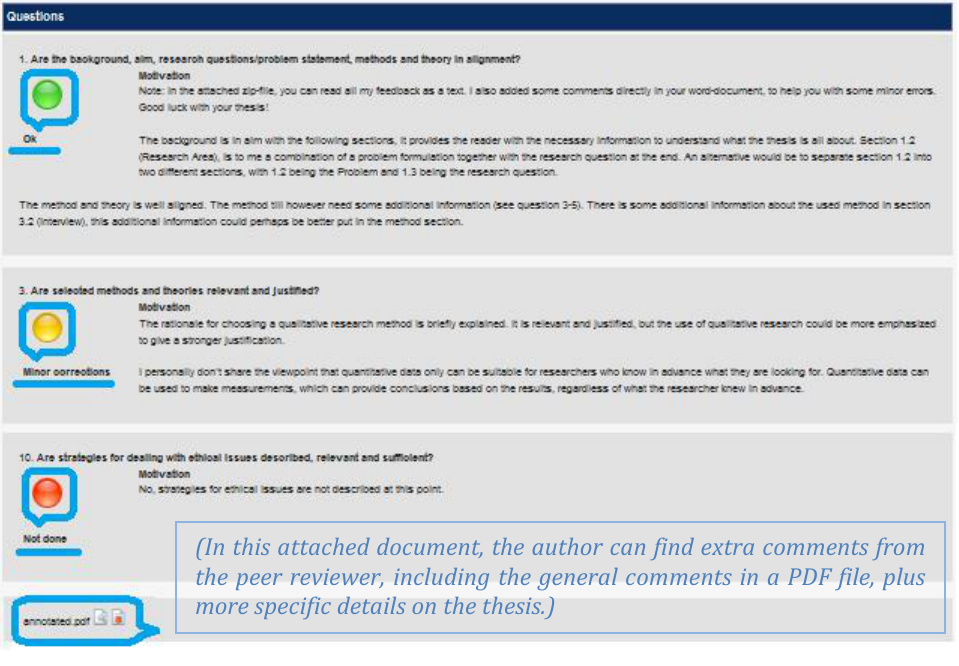
Figure 1. Part of an excellent peer review with additional comments in the attached file at the bottom of the